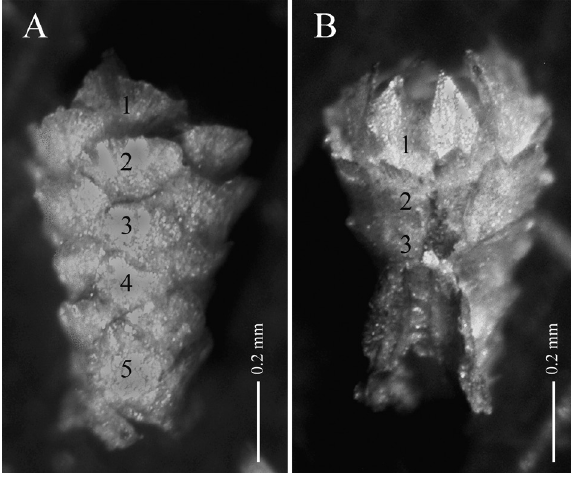
Fig . 16. – Thouarella vitjaz n. sp., holotype (IORAS IV-9- Alc-010-002): A, polyp on abaxial view; B, polyp on adaxial